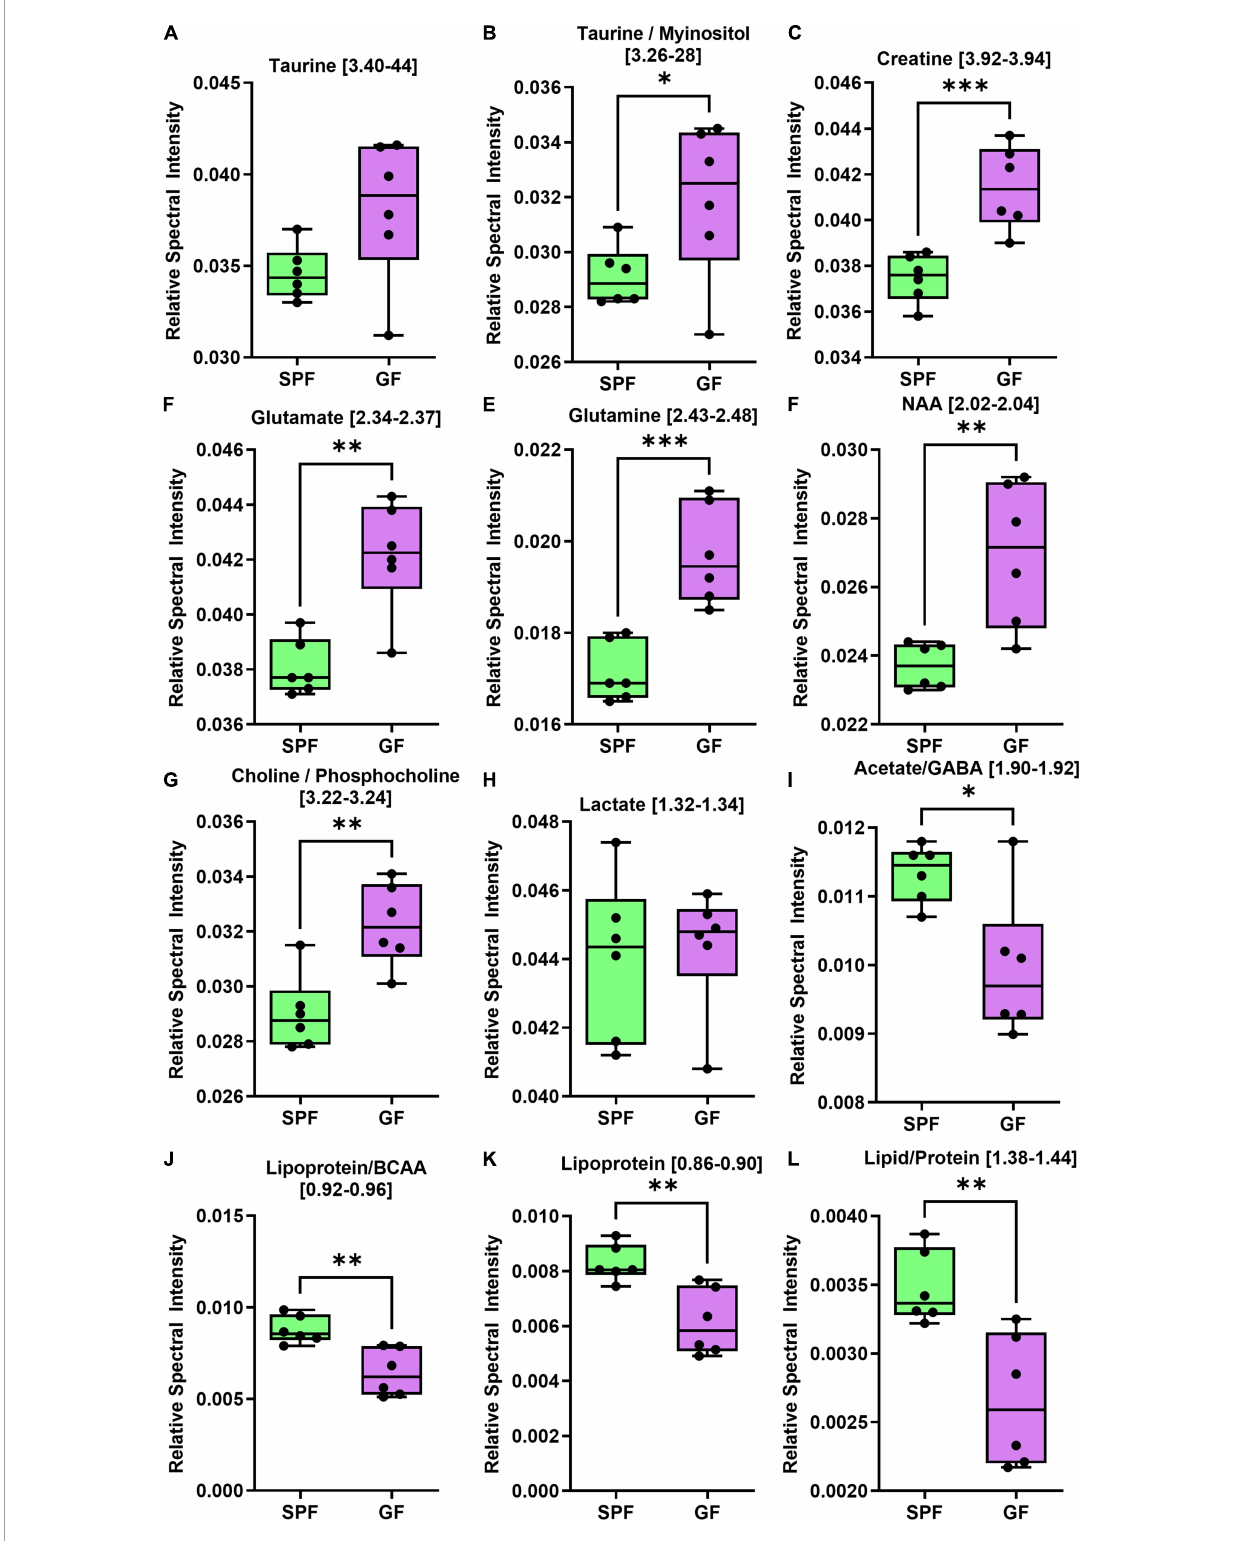
FIGURE4 The brain (cerebrum) metabolome is altered in GF ( n = 6) compared to SPF ( n = 6) mice. Boxplots represent the interquartile range (IQR), and whiskers display minimum/maximum values. (A) Taurine was increased in GF ( p = 0.0649). (B) Taurine/myoinositol ( p = 0.0481 ∗ ), (C) creatine ( p = 0.0010 ∗∗∗ ), (D) glutamate ( p = 0.0013 ∗∗ ), (E) glutamine ( p = 0.0006 ∗ ), (F) NAA ( p = 0.0046 ∗∗ ), and (G) choline/phosphocholine ( p = 0.0028 ∗∗ ) were all significantly increased in GF. (H) There were no significant variations in lactate ( p = 0.7975). (I) Acetate/GABA ( p = 0.0120 ∗ ), (J) lipoprotein/BCAA ( p = 0.0031 ∗∗ ), (K) lipoprotein ( p = 0.0033 ∗∗ ), and (L) lipid/protein ( p = 0.0043 ∗∗ ) were all significantly lower in GF. In the liver, several amino acids were increased in GF mice relative to SPF controls ( Figure 5 ), whereas certain microbial metabolites (succinate, TMAO) were significantly reduced in relative